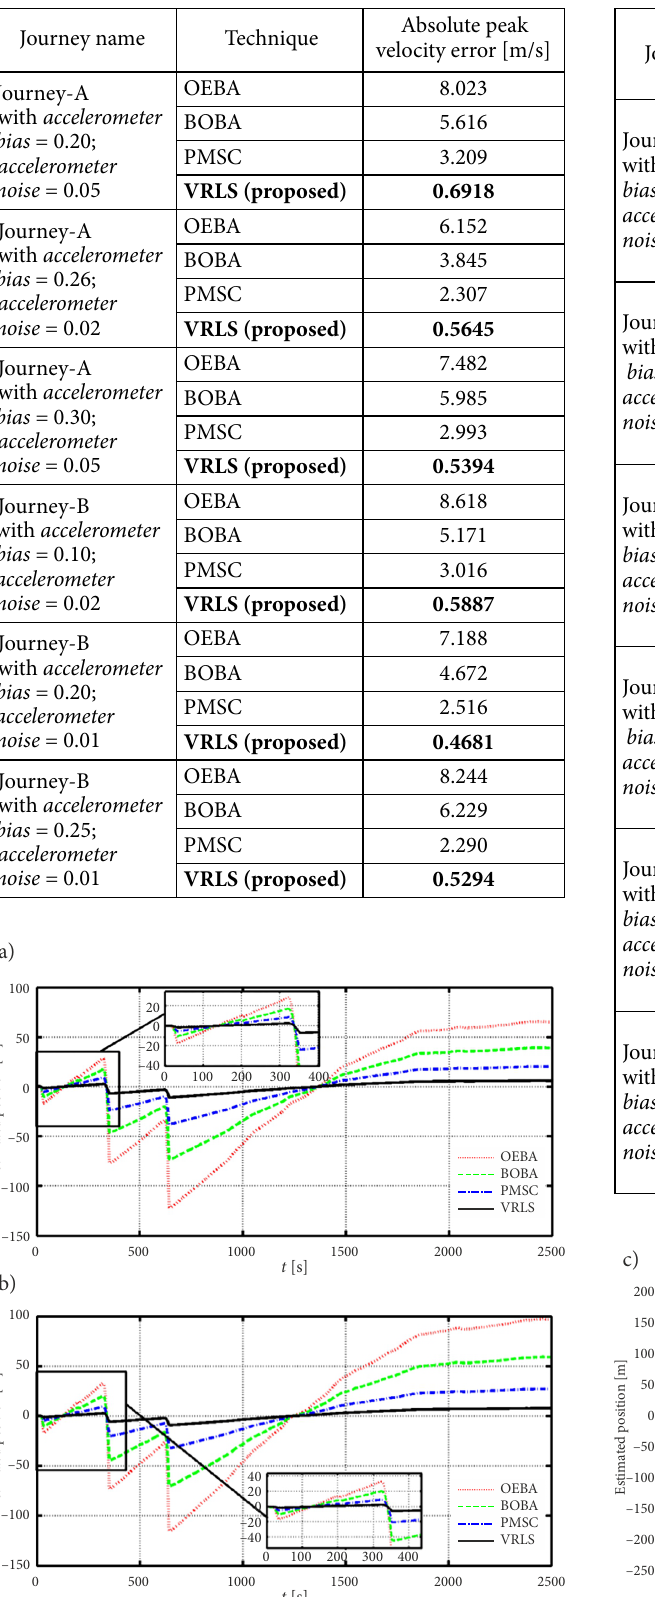
Table 4. Comparative performance of fusion-filtering techniques for position error estimation